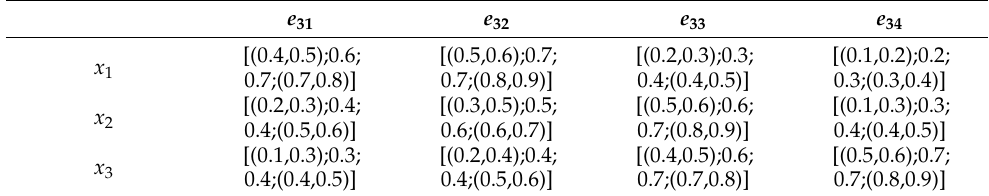
Table A4. The different risk evaluation values subordinated by influencing factors of B 3 at time t 1 .